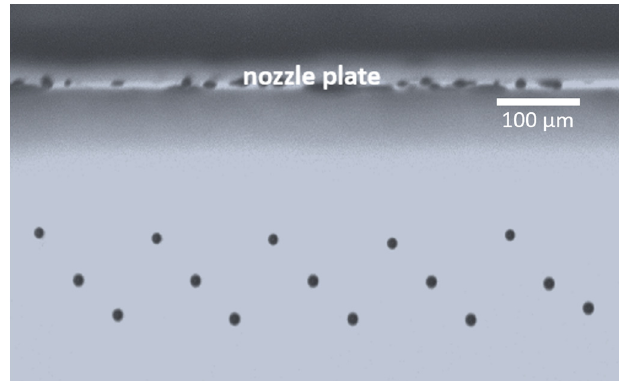
Figure 2. Typical jetting drop distribution of a 0.2 M (in yttrium) SDP ‐ Y 2 O 3 precursor ink and [DEA]/[Y] ratio of 4.5 after the tuning of the waveform excitation parameters displayed in Table 2.